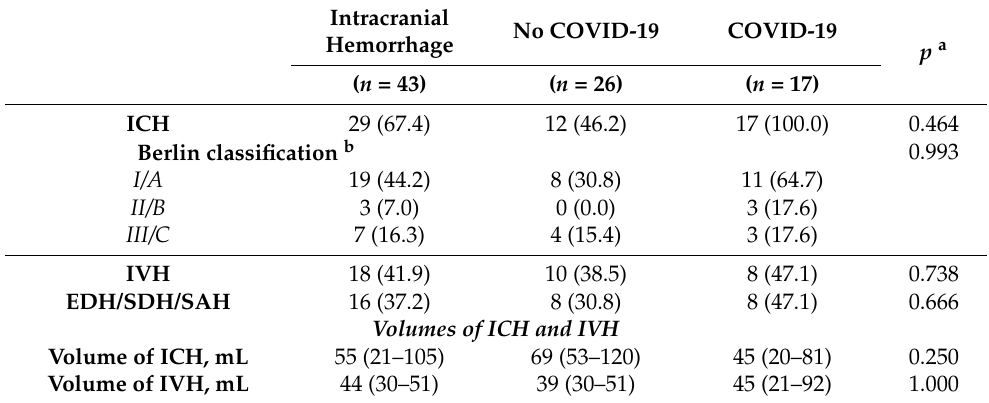
Figure 2. Types of intraparenchymal hemorrhage according to the classification proposed by Prinz and colleagues [6]. Data are given in % for patients without ( A ) and with COVID-19-associated ARDS ( B ). No intraparenchymal hemorrhage (ICH) includes patients with intraventricular or subarachnoid hemorrhage, epidural or subdural hematoma. Table 2. Types of intracranial hemorrhage.